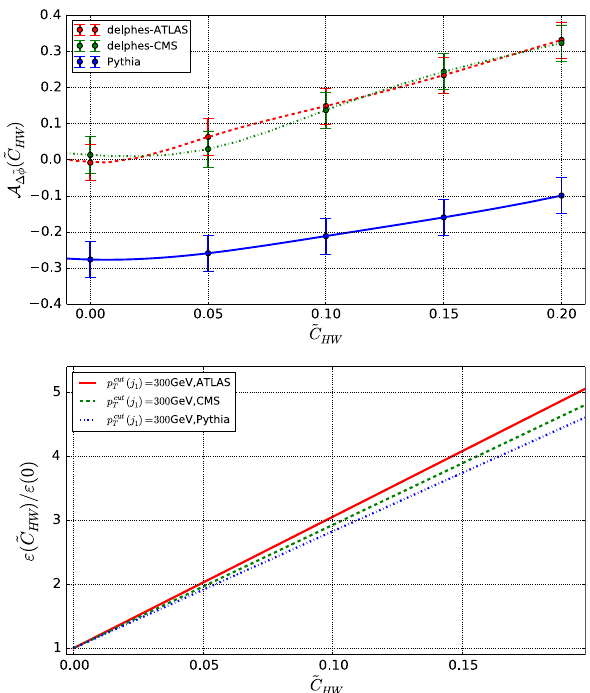
Fig. 13 Evaluation of the detector impact on the asymmetry (top) and efficiency (bottom) introduced in the context of VBF Higgs-boson production and defined in Sect. 6.2. We compare predictions solely including parton shower and hadronization effects (blue) to predictions embedding the modeling of the ATLAS (red) and CMS (green) detector